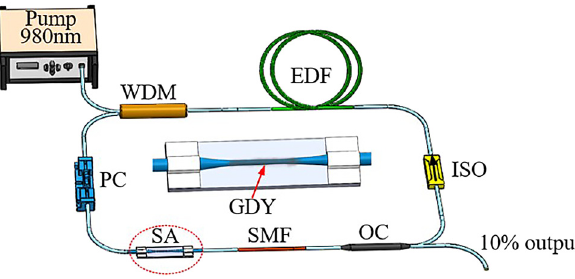
Figure 6: Experimental setup of GDY-based SA mode-locked EDF laser.